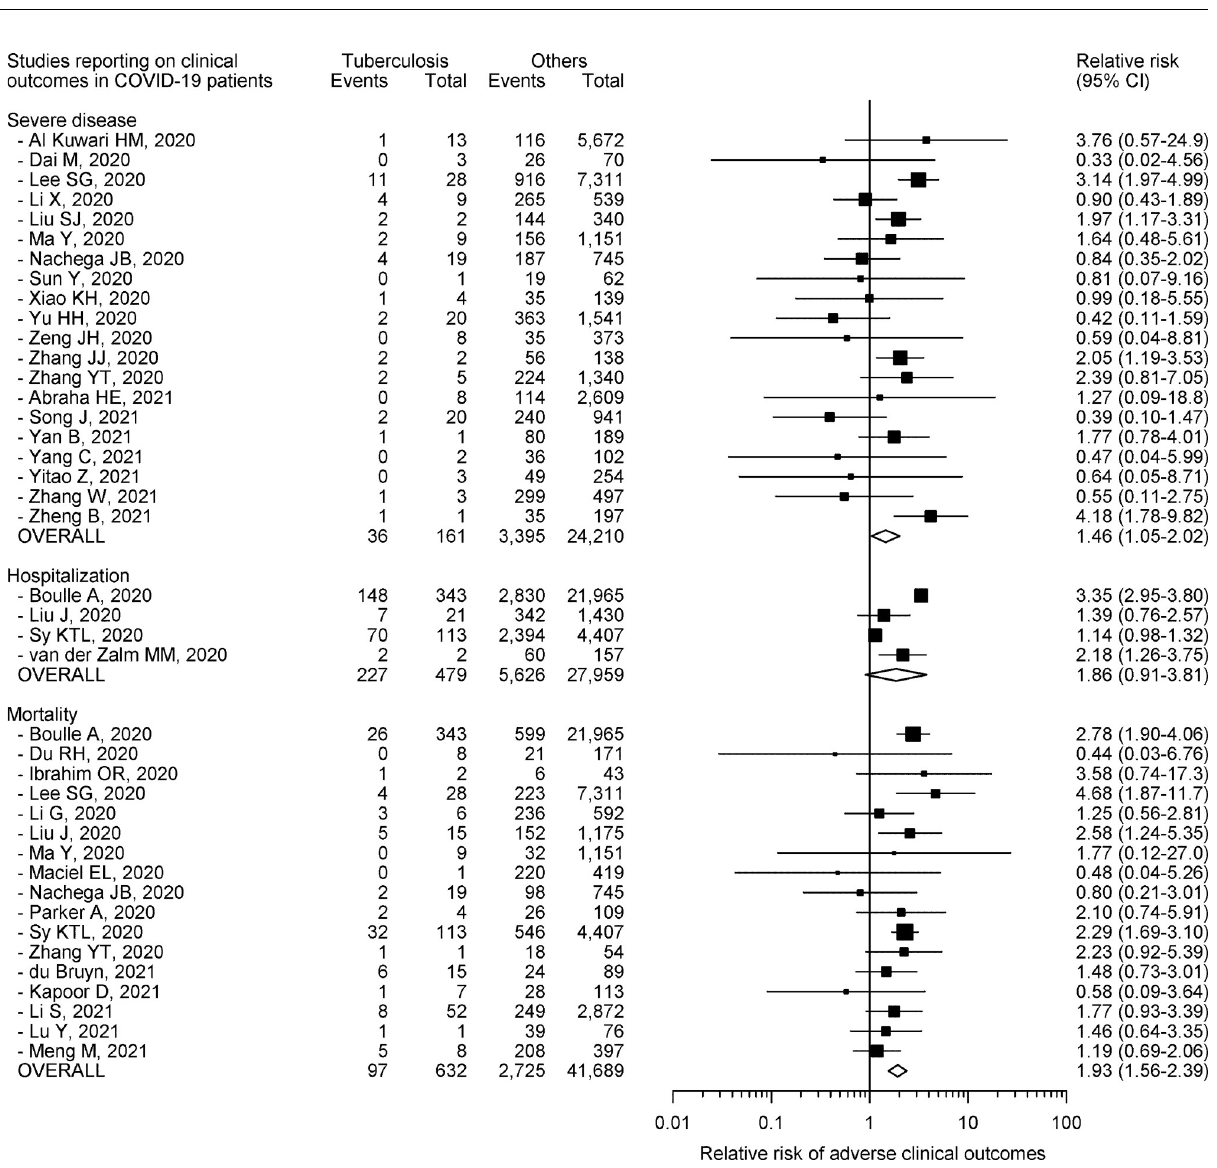
Fig 3. Relative risk, and corresponding 95% confidence intervals (CI), of adverse clinical outcomes among COVID-19 patients having tuberculosis.